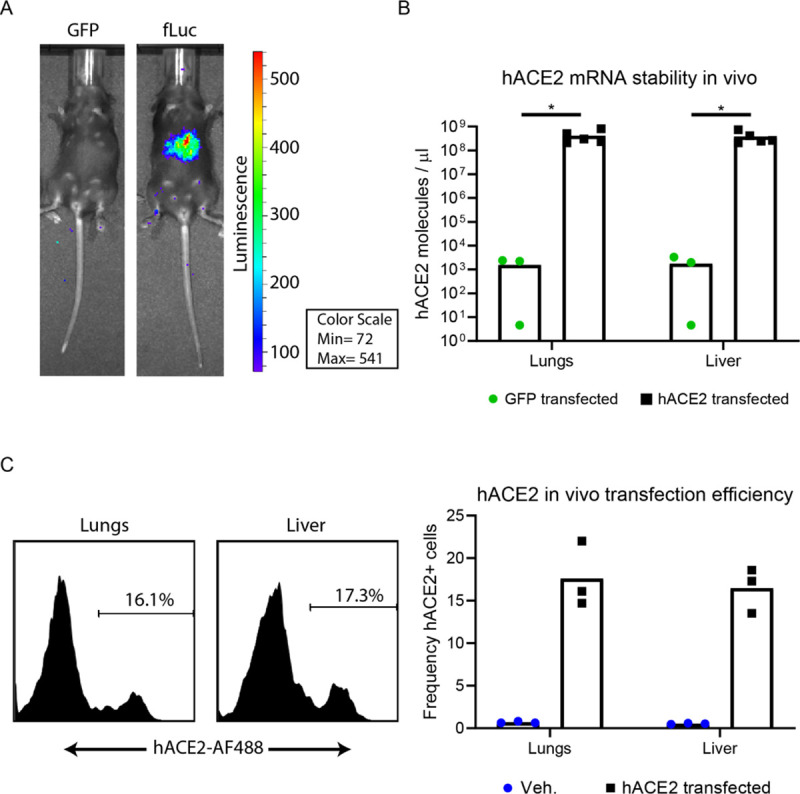
In vivo transfection efficiency.(A) fLuc reporter expression. 10 μg of fLuc or GFP mRNA was prepared in Polyplus in vivo-jet RNA in vivo transfection reagent and administered to Ifnar1-/- via IV and IN combination route. 24 hours following transfection, mice were injected IP with D-luciferin and imaged via IVIS 15 minutes later. (B) hACE2 mRNA stability in vivo. Ifnar1-/- mice were transfected with 10 μg of GFP or hACE2 mRNA. 24 hours post transfection, mice were euthanized and liver and lung tissue homogenized in TriReagent RT for RNA extraction. hACE2 mRNA levels were quantified from extracted RNA via qRT-PCR. Statistical significance was determined by Mann-Whitney test (p = 0.03 and p = 0.03, in the lungs and liver, respectively) (C) hACE2 in vivo transfection efficiency, Ifnar1-/- mice were transfected with 10 μg of hACE2 mRNA or vehicle alone. 24 hours post transfection, mice were euthanized and liver and lung tissue were dissociated into single cell suspensions and stained with a human-ACE-2 specific antibody, followed by an AF488-conjugated anti-human secondary antibody. Live cells were analyzed on an Attune focusing flow cytometer and are represented as frequency of hACE2 expressing cells.